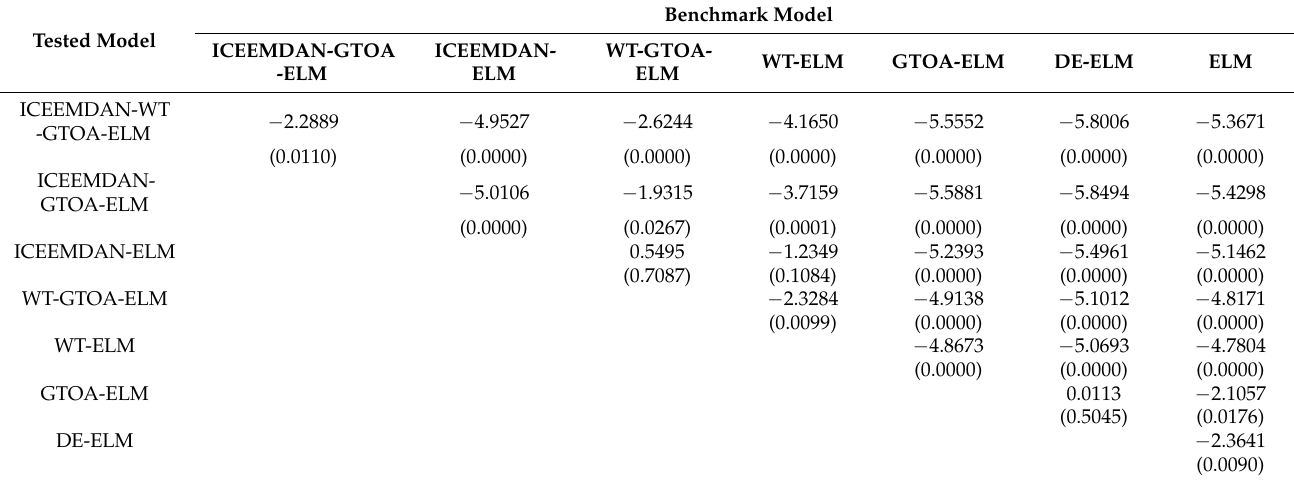
Table 3. DM test results of three-step ahead forecasting of